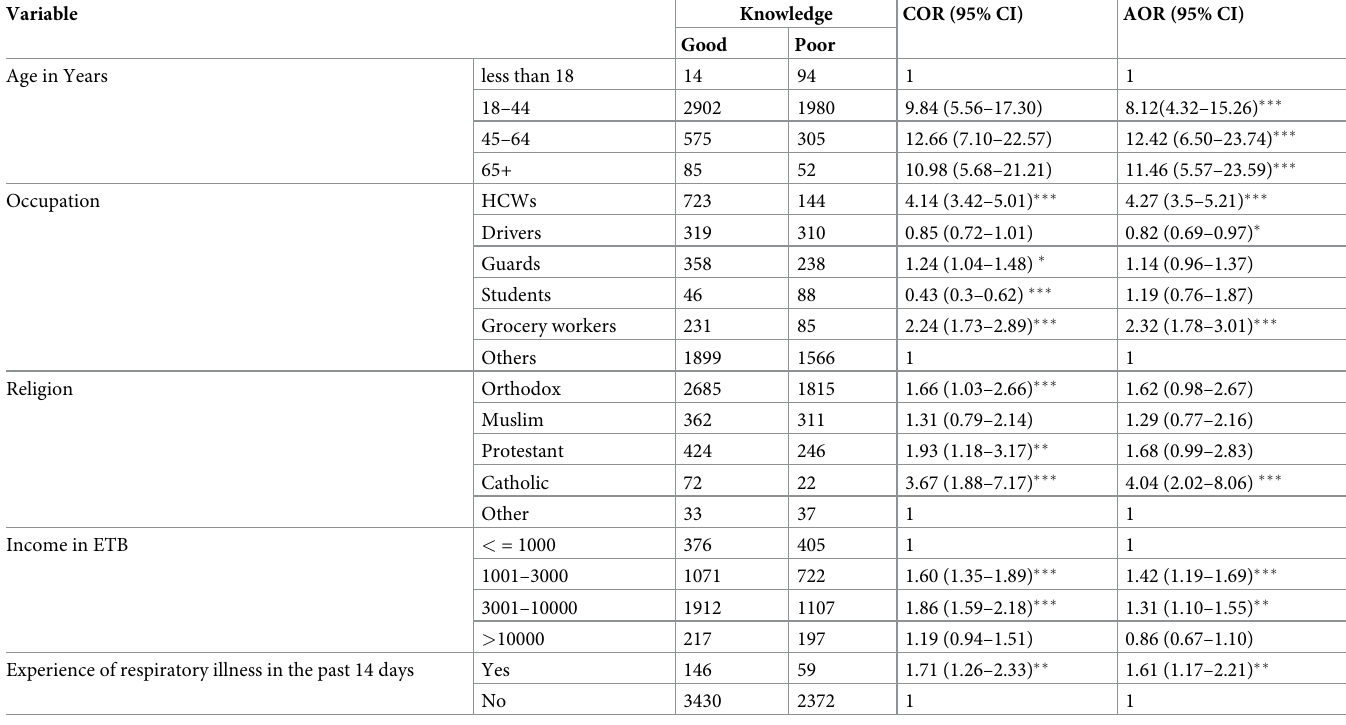
Table 4. Factors associated with knowledge on the prevention of COVID-19 among participants, Addis Ababa, Ethiopia, 2020.